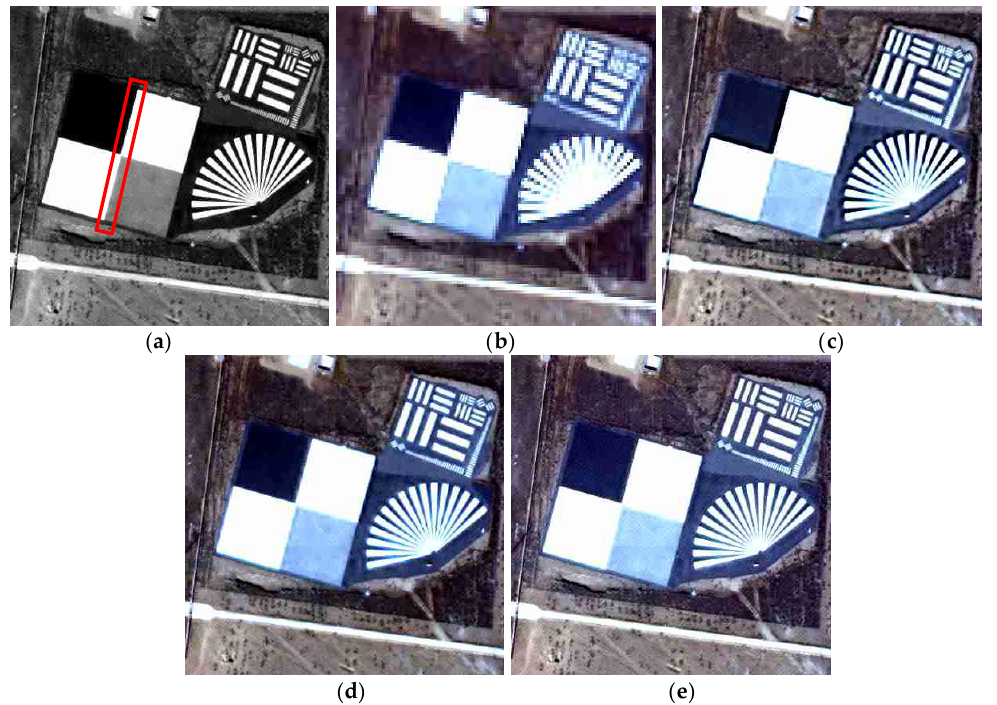
Figure 6. The details of the edge target according to each algorithm in the Salon region: ( a ) panchromatic image; ( b ) resized multispectral image; ( c ) image pansharpened by the MTF-GLP; ( d ) image pansharpened by the GSA; ( e ) image pansharpened by the GFNDVI.